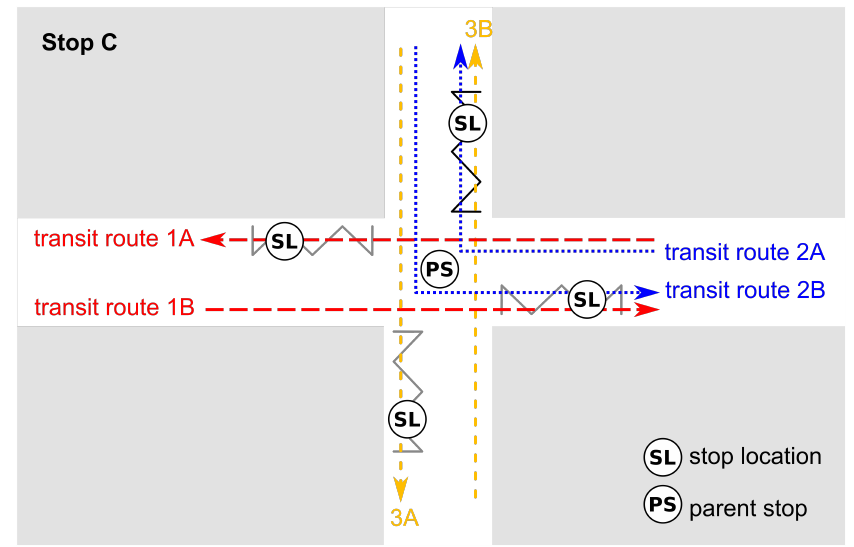
Figure 2. Difference between parent stop and stop locations: stop C (see Figure 1) at an intersection is passed by three bus transit lines with two transit routes